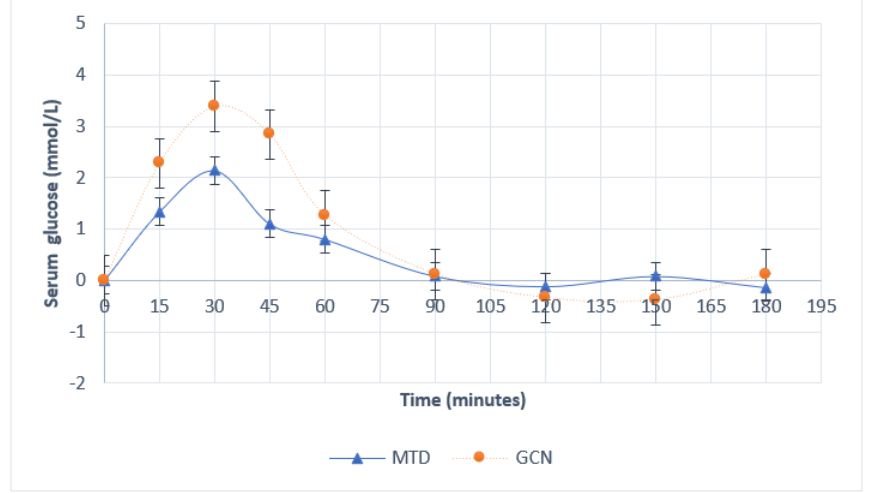
Figure 1. Serum glucose concentrations over time. Error bars represent SEM.